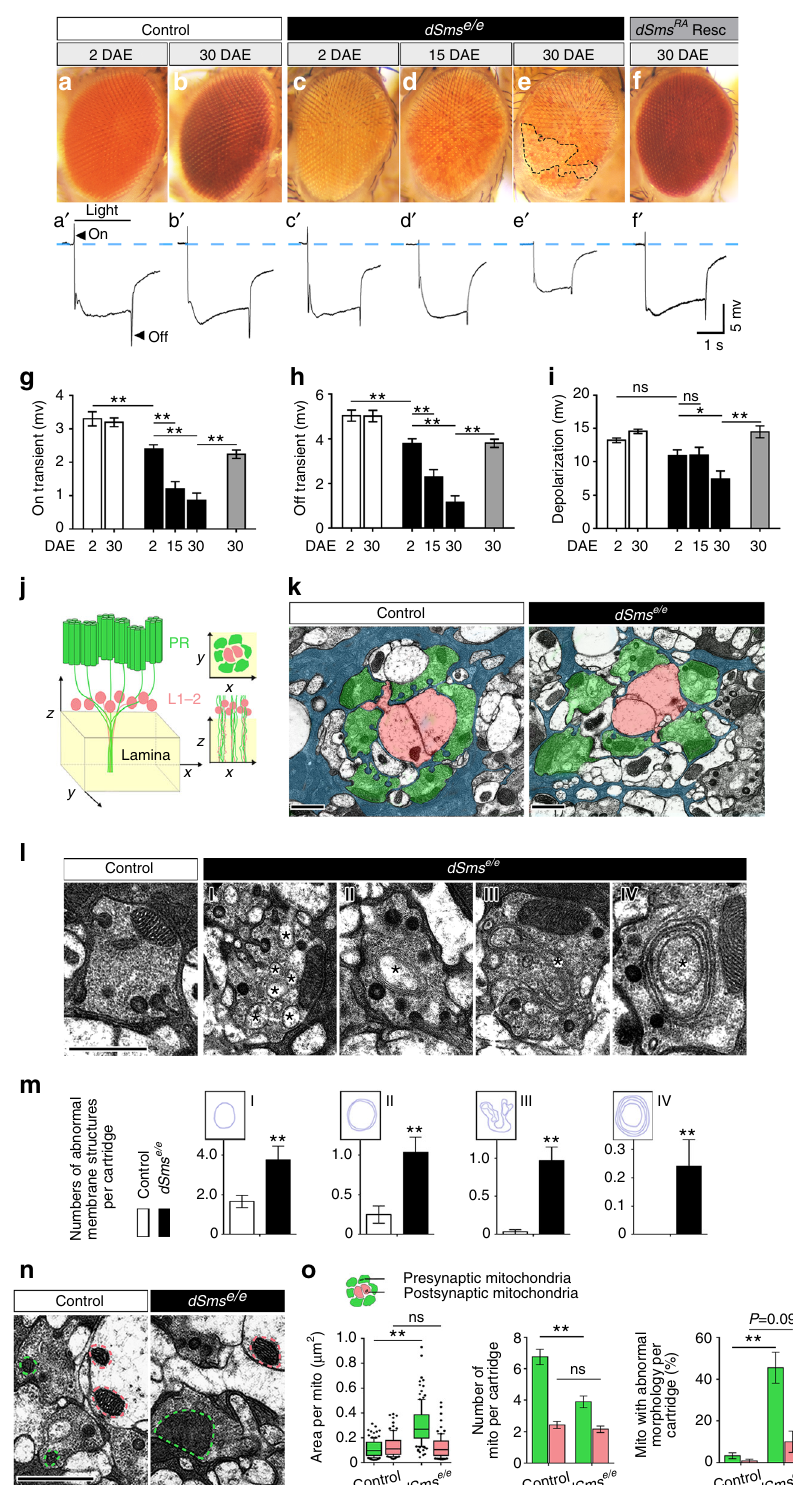
and decreased amounts of mature CtsL, indicating a de fi cit in lysosomal processing (Fig. 5e, f and Supplementary Fig. 6b). Next we analyzed lysosomal function in cultured SRS patient dermal fi broblasts. Double immunostaining for LAMP1 and cathepsin D (CtsD) showed a LAMP1-positive ring structure often surrounding CtsD in control human fi broblasts (Fig. 5g), whereas fi broblasts from the SRS patients presented